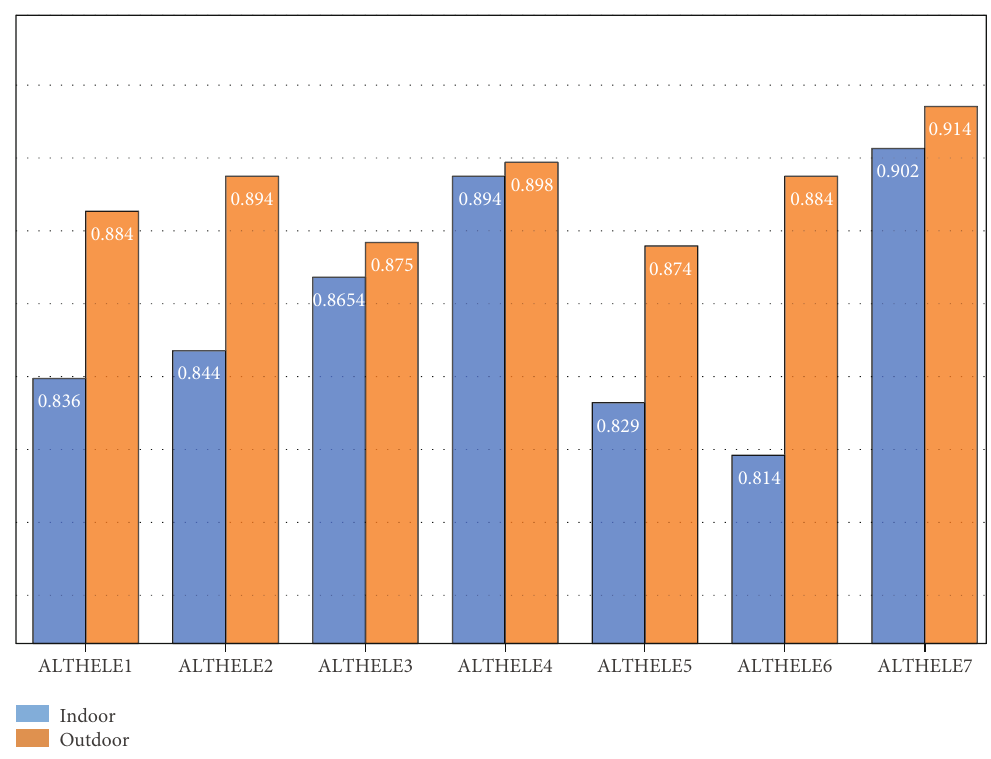
Figure 4: Performance on di ff erent athletes.